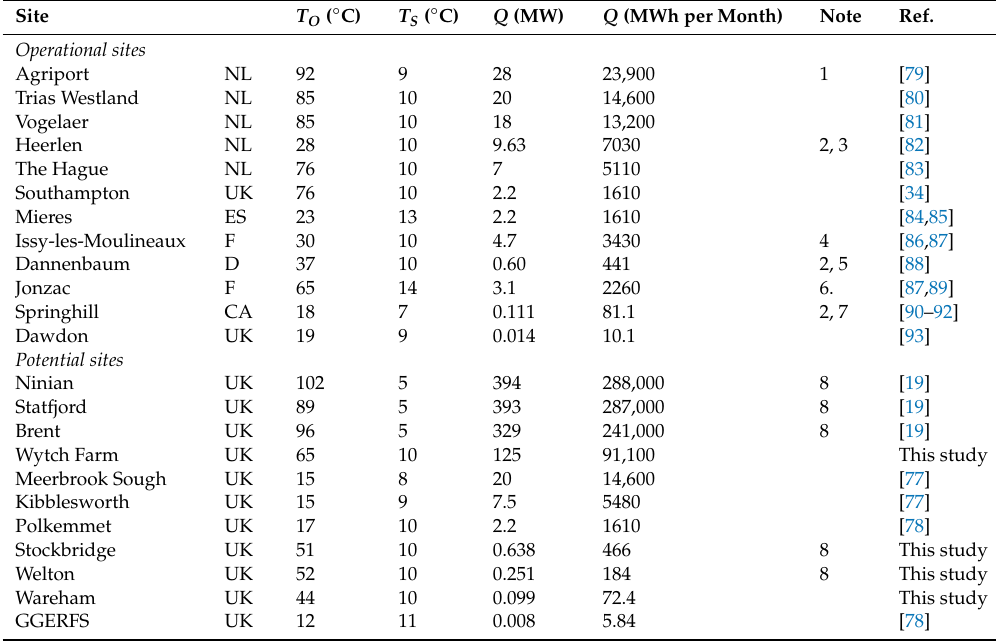
Table 8. Comparison of low-temperature geothermal